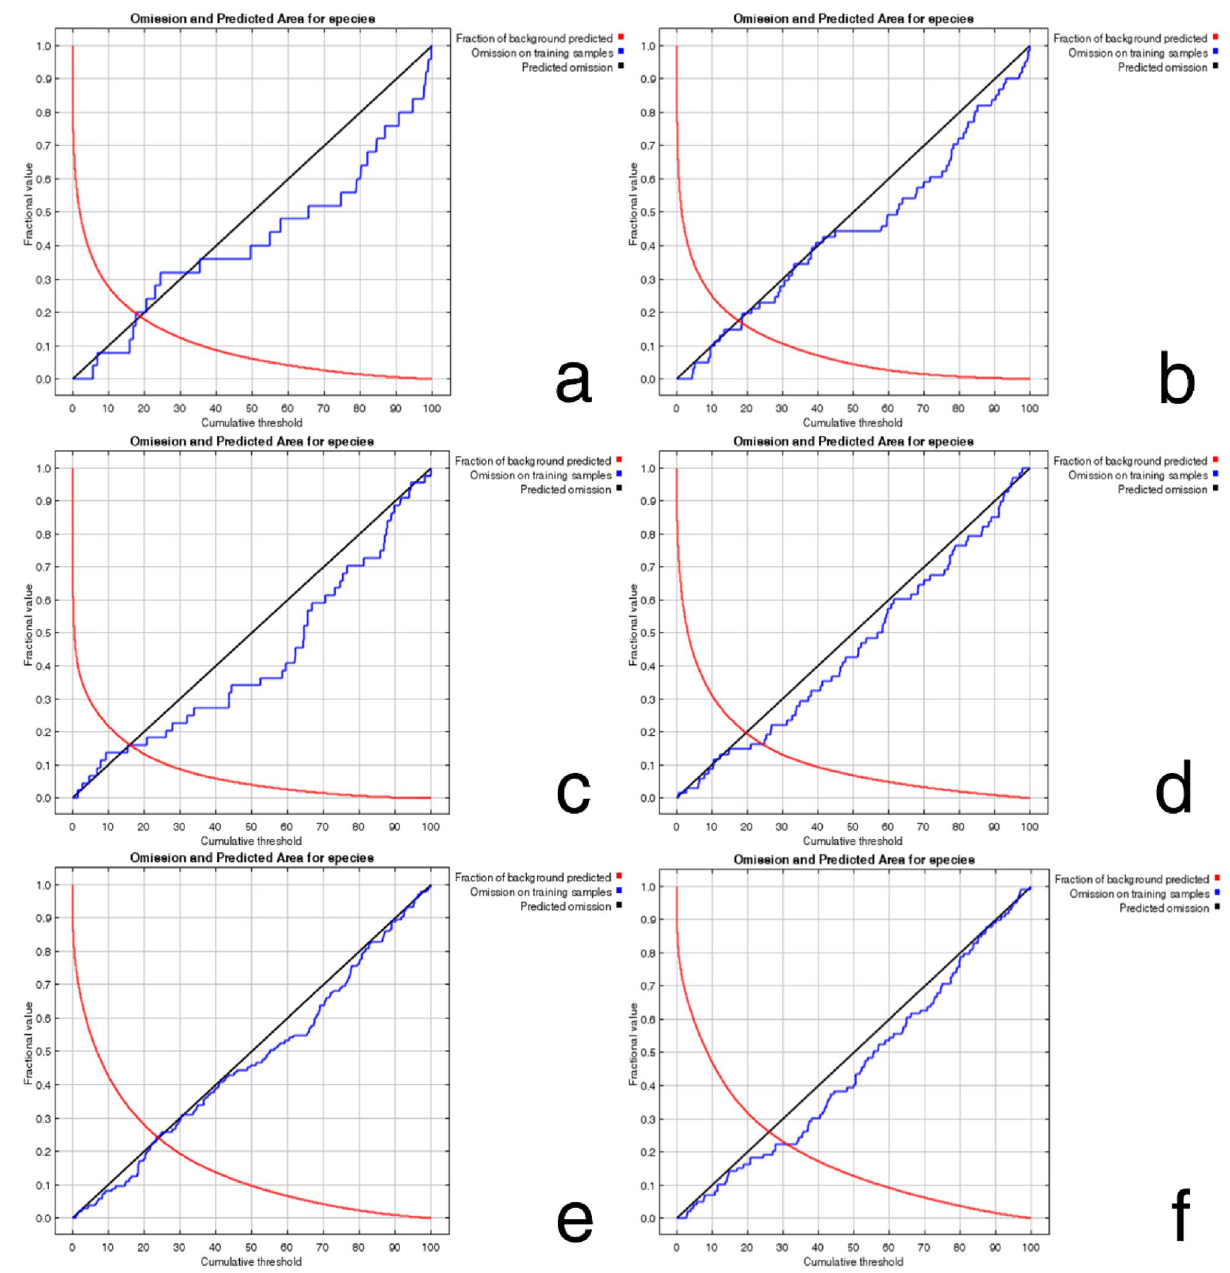
Figure 2. Omission rate of six important quarantine species: ( a ) Crenidorsum aroidephagus , ( b ) Aleurothrixus trachoides , ( c ) Paraleyrodes minei , ( d ) Nasonovia ribisnigri , ( e ) Macrosiphum euphorbiae , ( f ) Viteus vitifoliae . Fraction of background predicted (red line), omission rate for training samples (blue line), and predicted omission rate (black line). Figures were created using R version 4.04 (https:// www.r- proje ct.